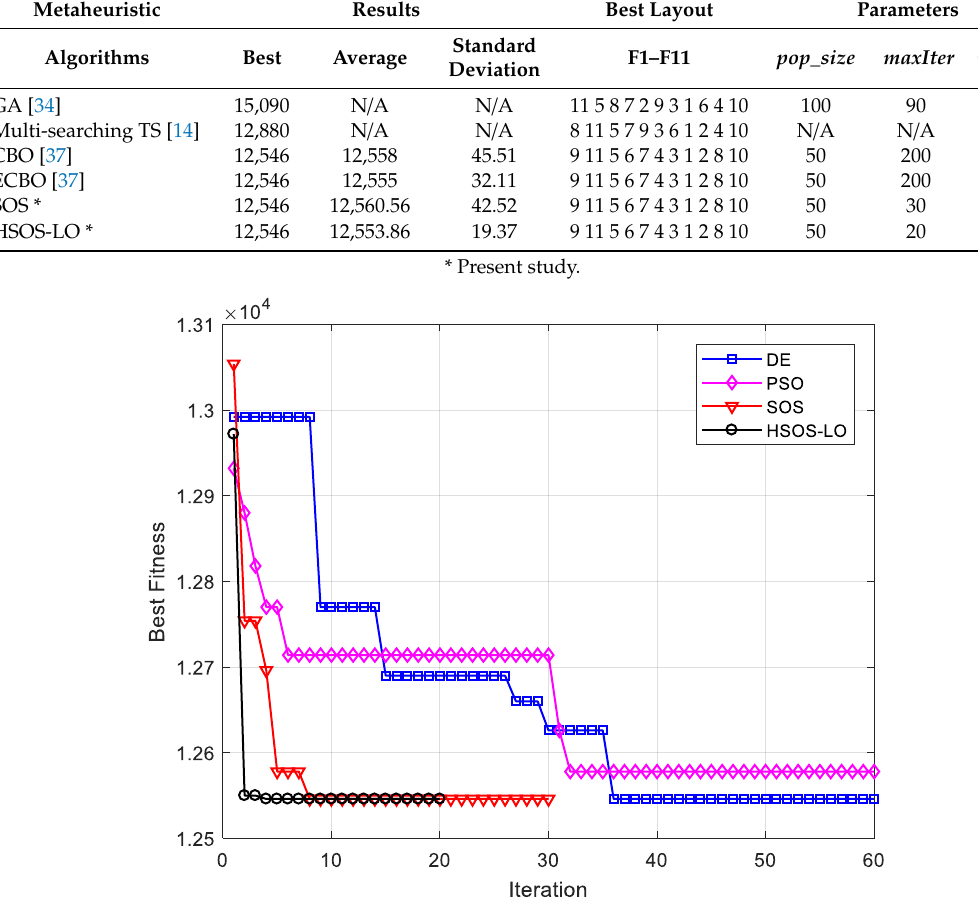
Figure 4. Convergence graphic of metaheuristic algorithms for Case 1.